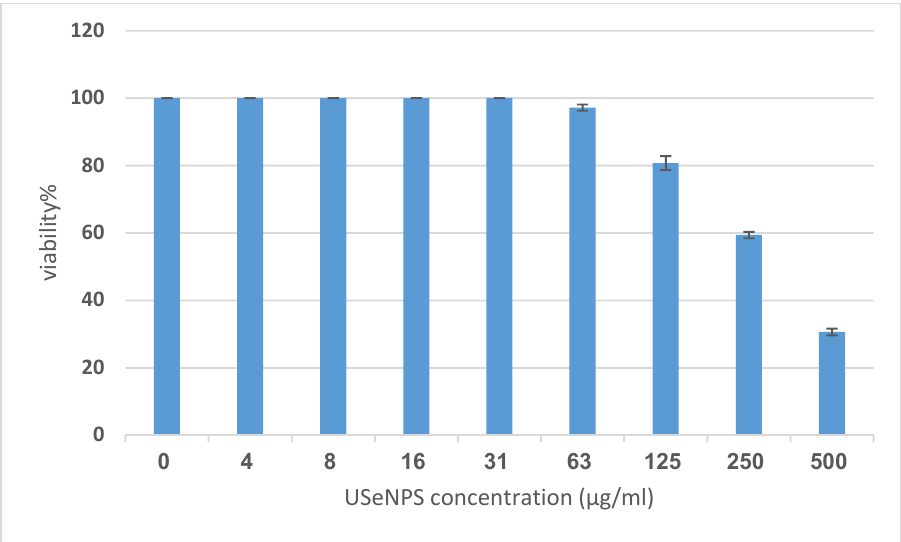
Figure 10. The cytotoxicity of USeNPS against mammalian cells from African green monkey kidney (Vero) with 50% cell cytotoxic concentration (CC 50 ) = 331.76 ± 4.79 µg/mL.